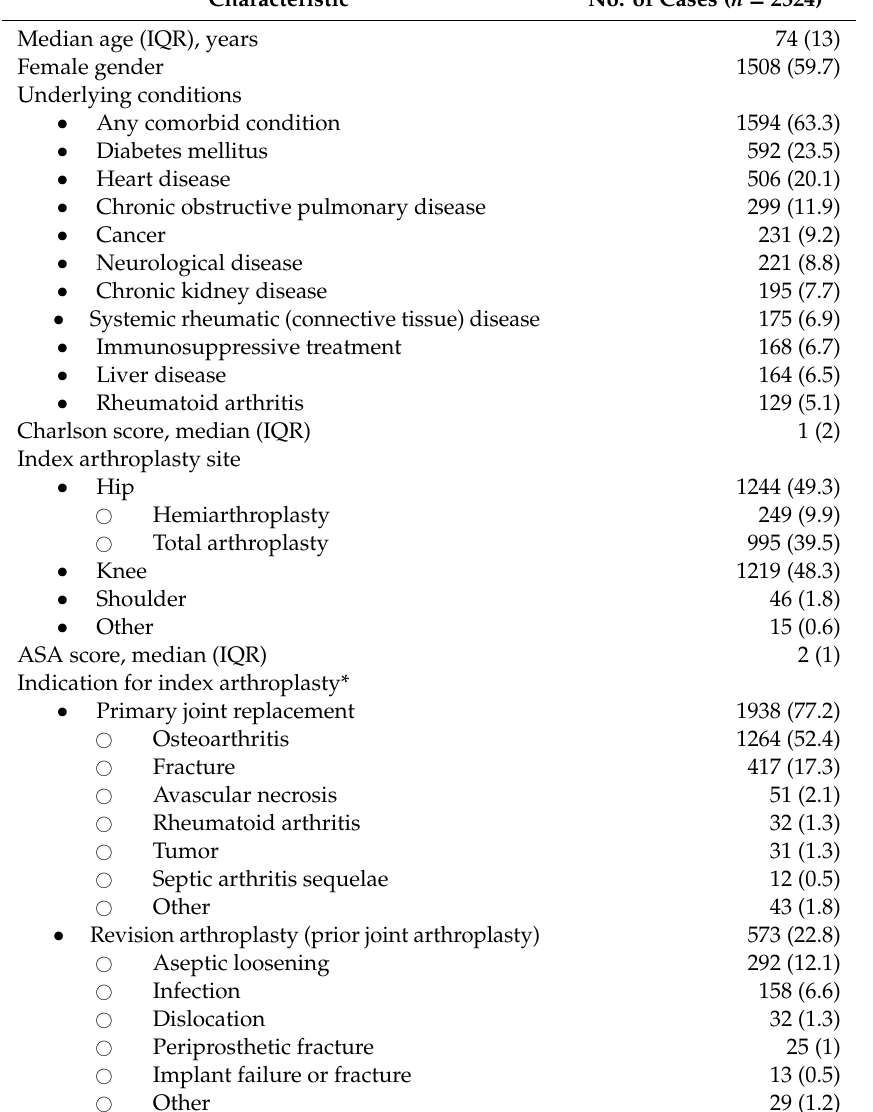
Table 1. Characteristics of patients with prosthetic joint infection diagnosed between 2003 and 2012.